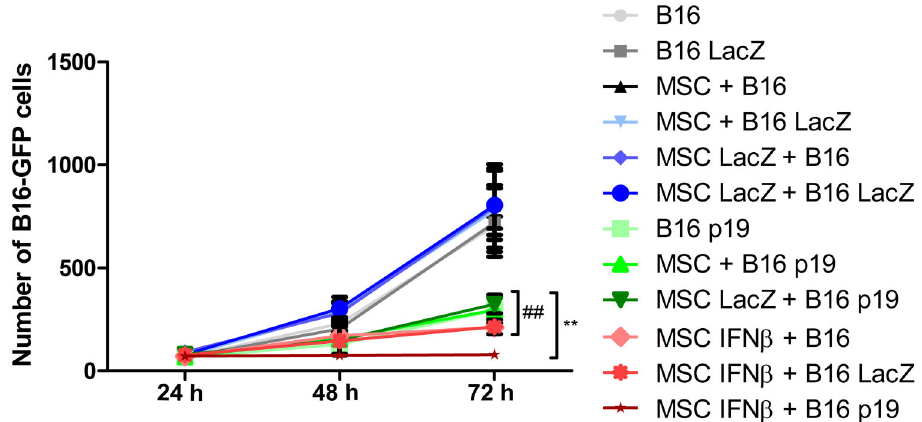
Figure 3. p19Arf sensitizes B16 cells to interferon- b (IFN b ) produced by mesenchymal stem cells (MSCs). MSCs were either not transduced (MSC) or transduced with AdRGD-CMV-LacZ (MSC LacZ) or AdRGD-PG-IFN b (MSC IFN b ) and then co-cultured with B16 cells with stable expression of eGFP (B16-GFP) that were also either not transduced (B16) or transduced with either AdRGD-CMV-LacZ (B16 LacZ) or AdRGD-PG-p19 (B16 p19). At the indicated time points, cells were photographed and the B16 cell population was counted based on presence of eGFP expression. Data are reported as the average and standard error from three independent experiments. **P o 0.01 comparing individual experimental conditions with the control (MSC LacZ + B16 LacZ, 72 h) using the Student ’ s t -test. ## P o 0.01 comparing individual experimental conditions with MSC IFN b + B16 p19 (72 h) using Student ’ s t